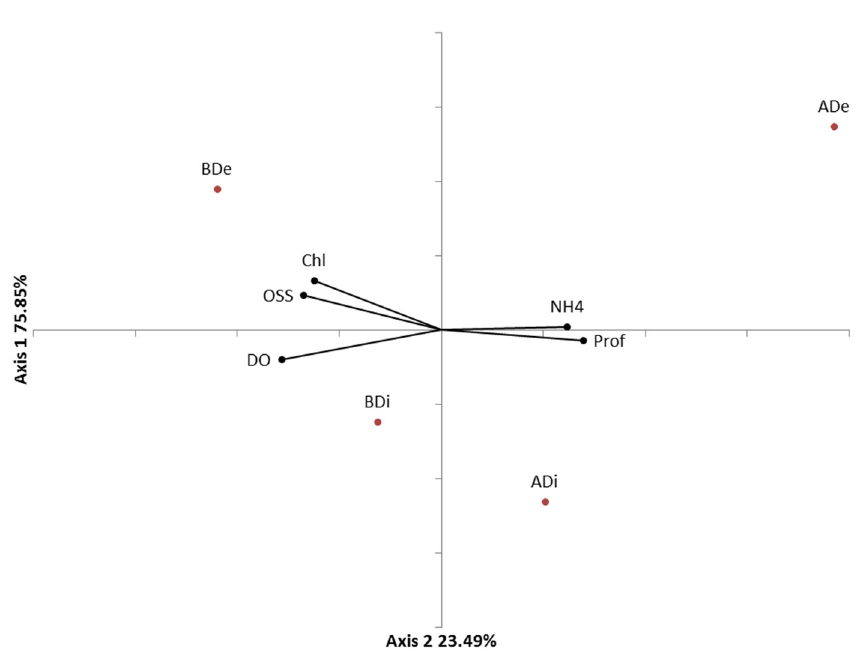
Figure 4. Correspondence Canonical Analysis (CCA) between environmental- Chlorophyll (Chl), Organics suspended solids (OSS), dissolved oxygen (DO), Profundity (Prof) and ammonia (NH4) and biological variables- Archaeal density (ADe) Bacterial density (BDe), Archaeal diversity (ADi) and Bacterial diversity (BDi) from Itupararanga Reservoir, SP, Brazil.